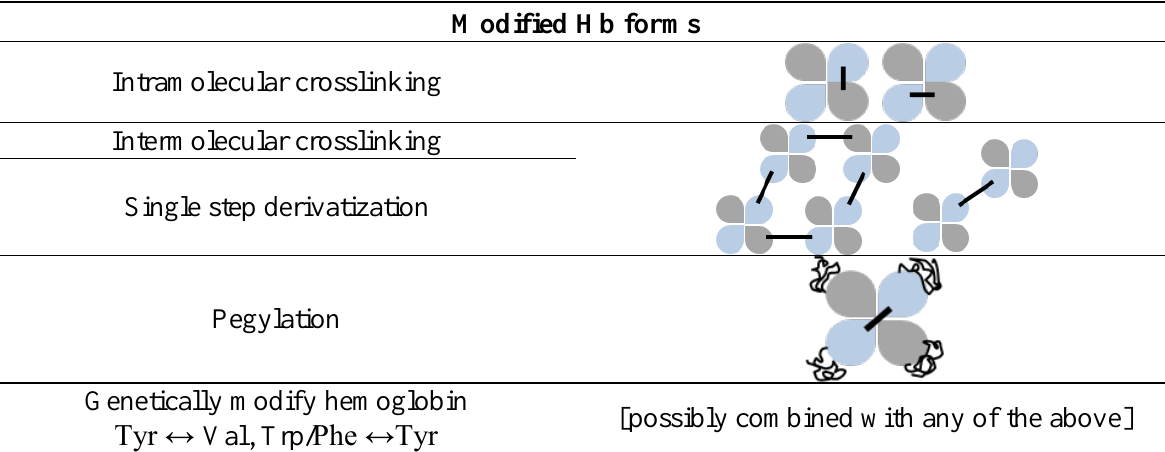
Table 1. Options for hemoglobin